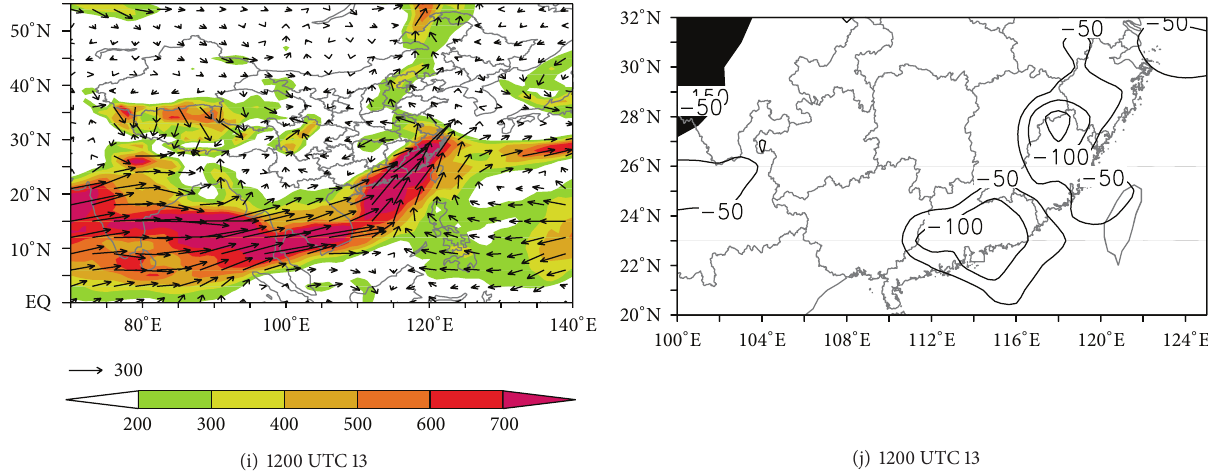
⃗ IWV, and (b), (d), (f), (h), and (j) for the DIWV.